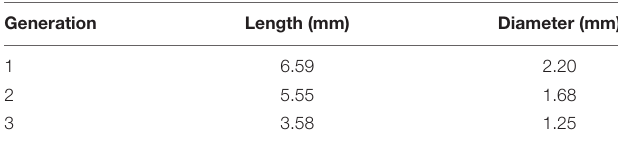
TABLE 1 | Dimensions of the airway-on-chip